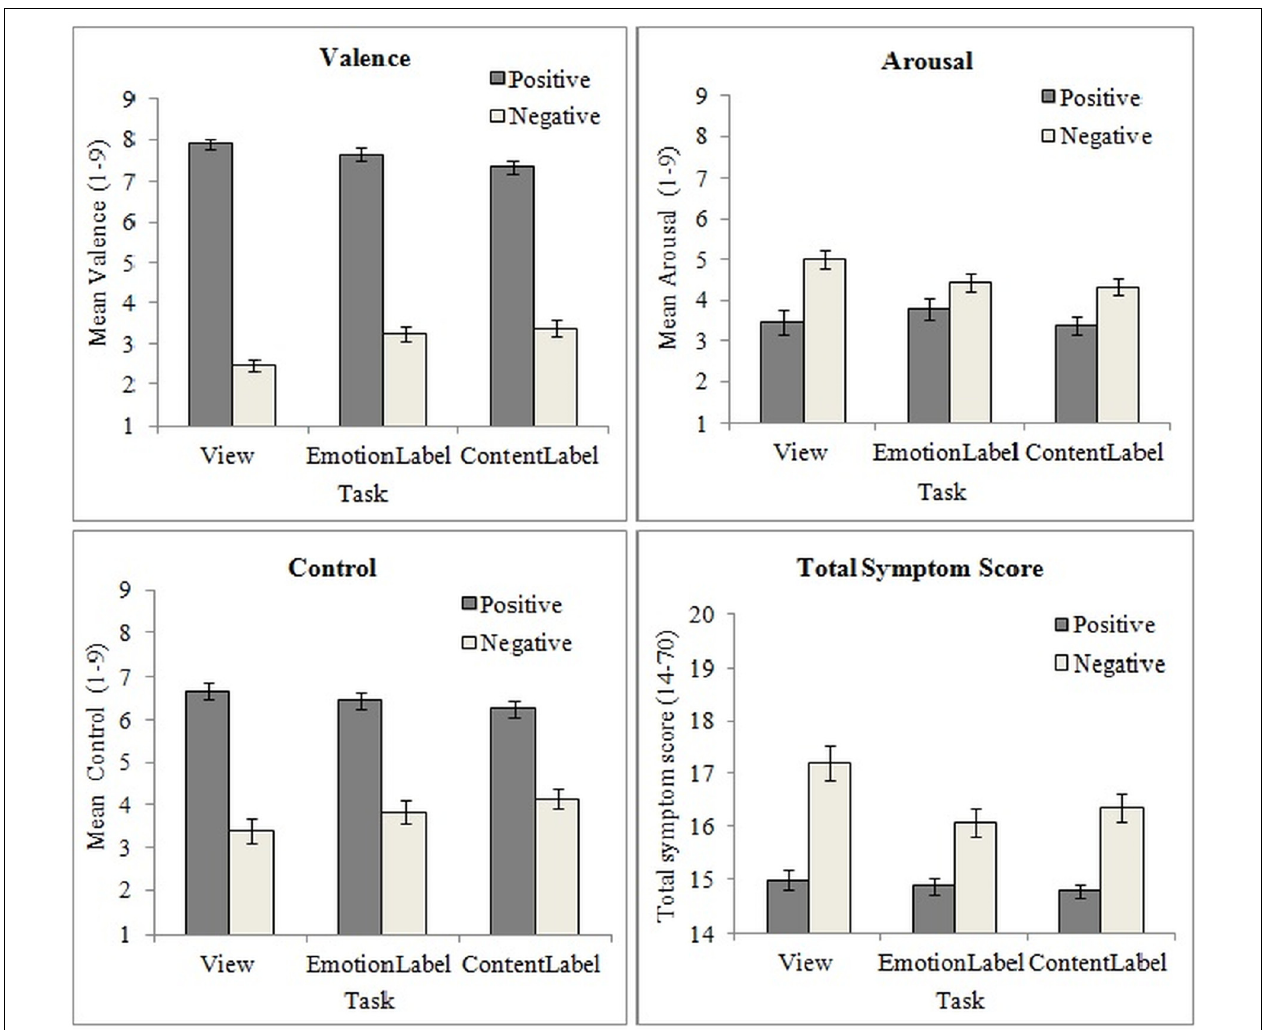
FIGURE 1 | Emotion × Task interaction effect for valence (top left), arousal (top right) and control ratings (bottom left) and symptom reports (bottom right) after each trial.